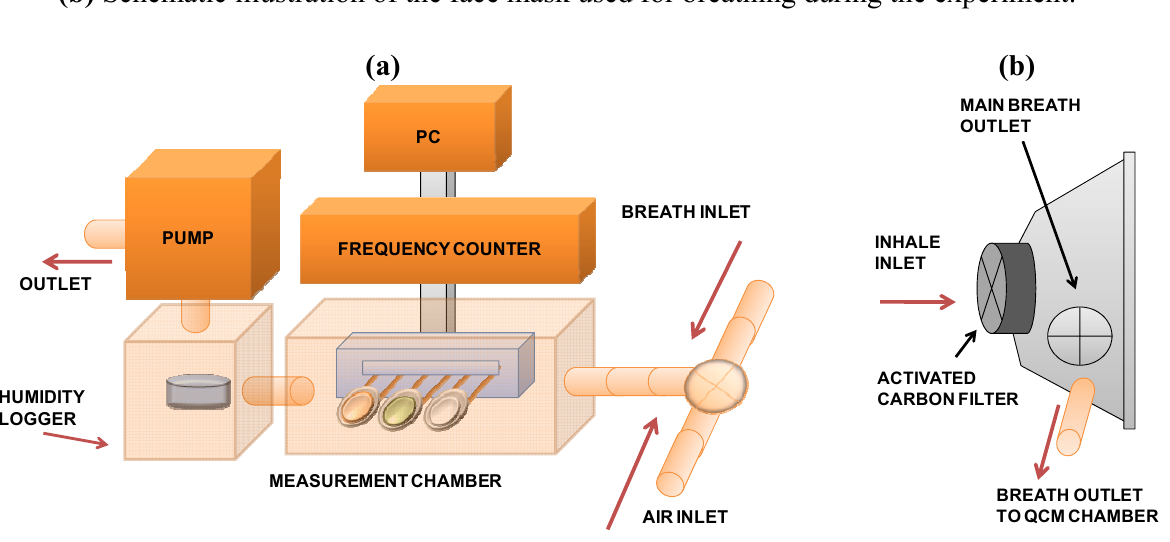
Figure 2. (a) Experimental set-up used for breathing monitoring by QCM sensors; (b) Schematic illustration of the face mask used for breathing during the